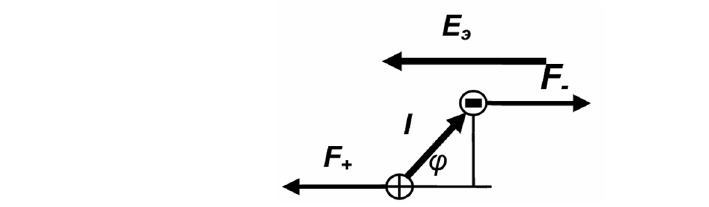
Figure 1 – Interaction of external field Е э with electric dipole Рис . 1 – Взаимодействие внешнего поля Е э с электрическим диполем Слика 1 – Интеракција спољашњег поља Е э с електричним